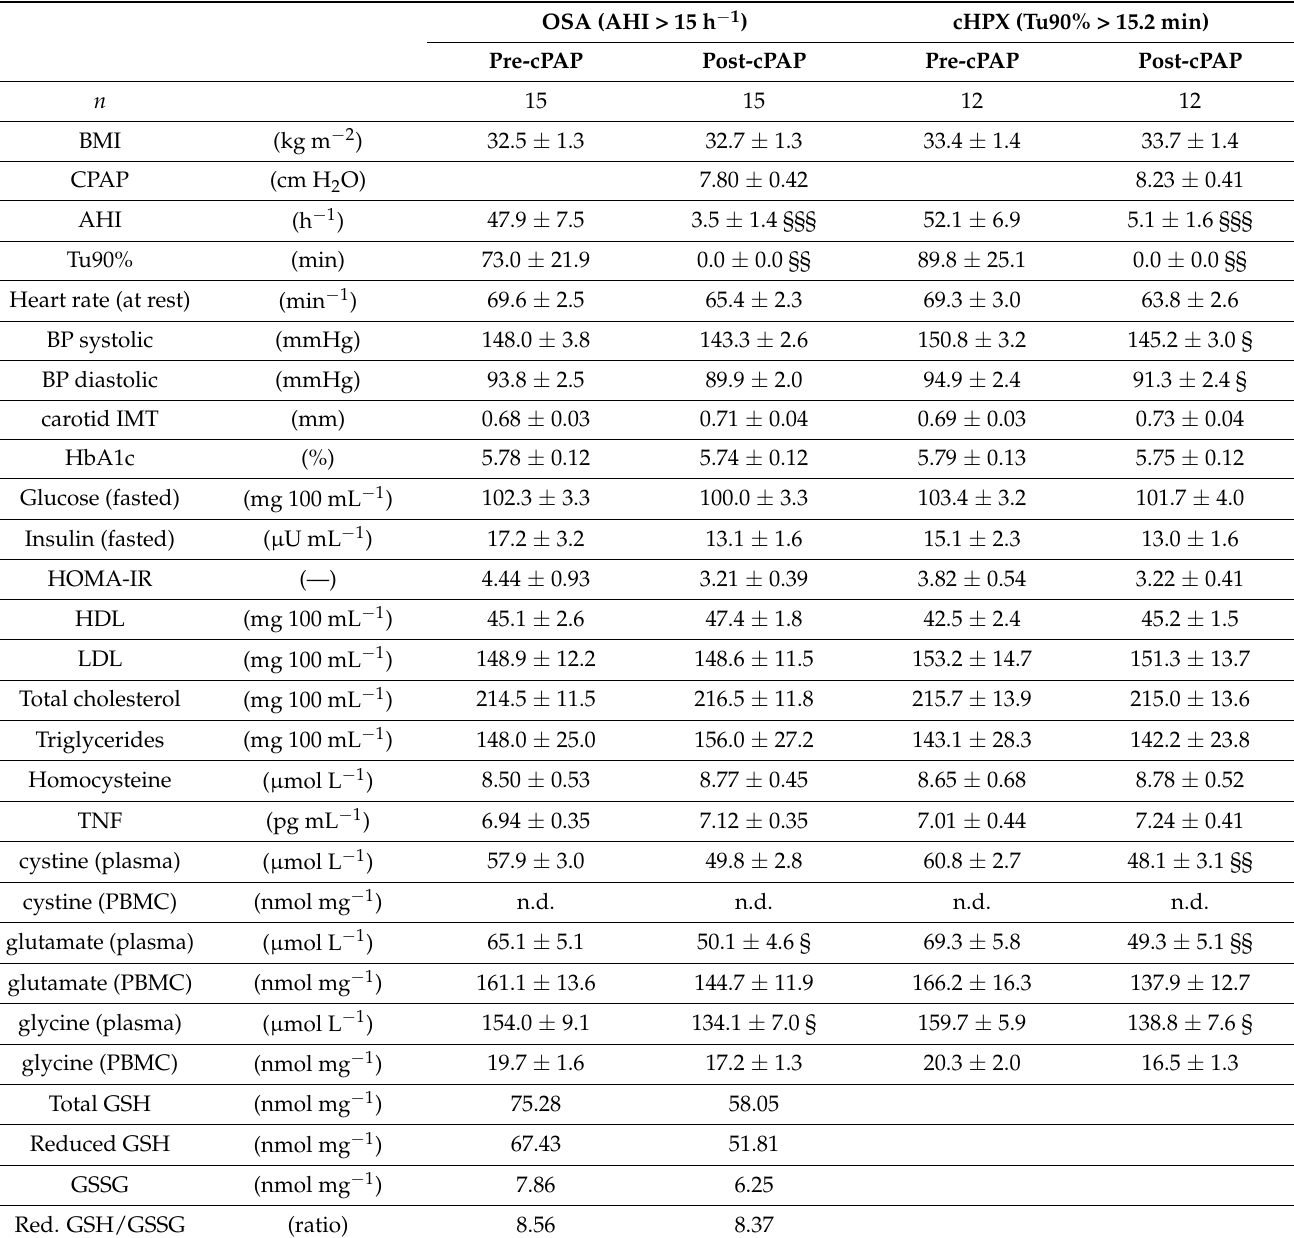
Table 3. Pre- and post-CPAP values of BMI, sleep data, vascular risk factors, as well as plasma and PBMC amino acid and PBMC